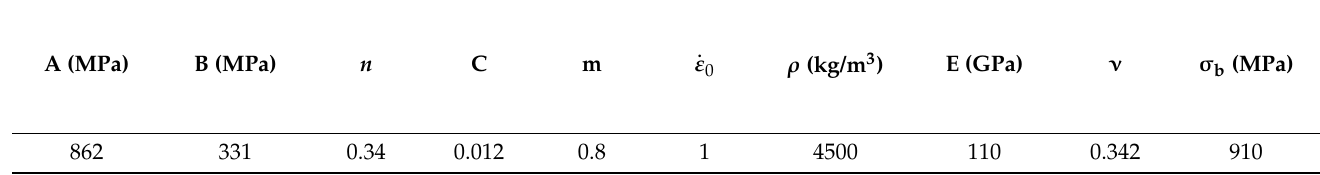
Table 1. Johnson–Cook parameters and mechanical properties of Ti-6Al-4V titanium alloy.